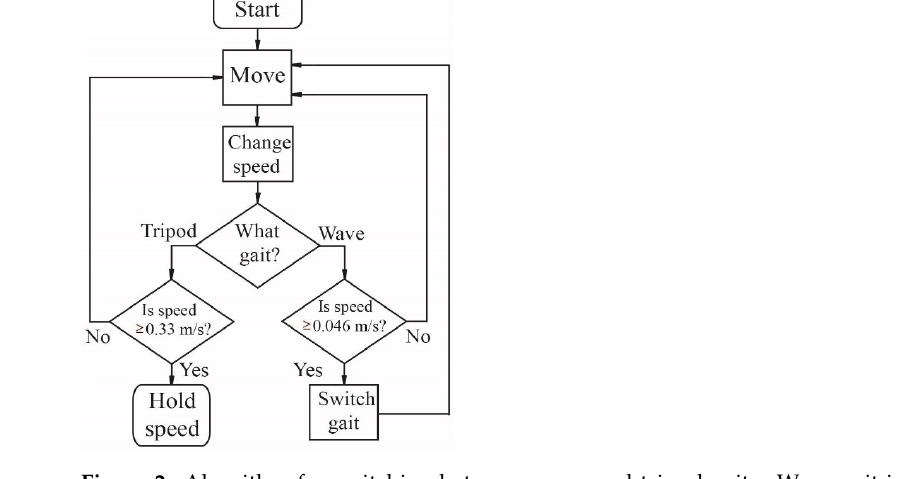
Figure 2. Algorithm for switching between wave and tripod gaits. Wave gait is used when the movement speed is lower than 0.046 m/s; tripod gait is used when the movement speed is higher than 0.046 m/s until the speed reaches a maximum value of 0.33 m/s.